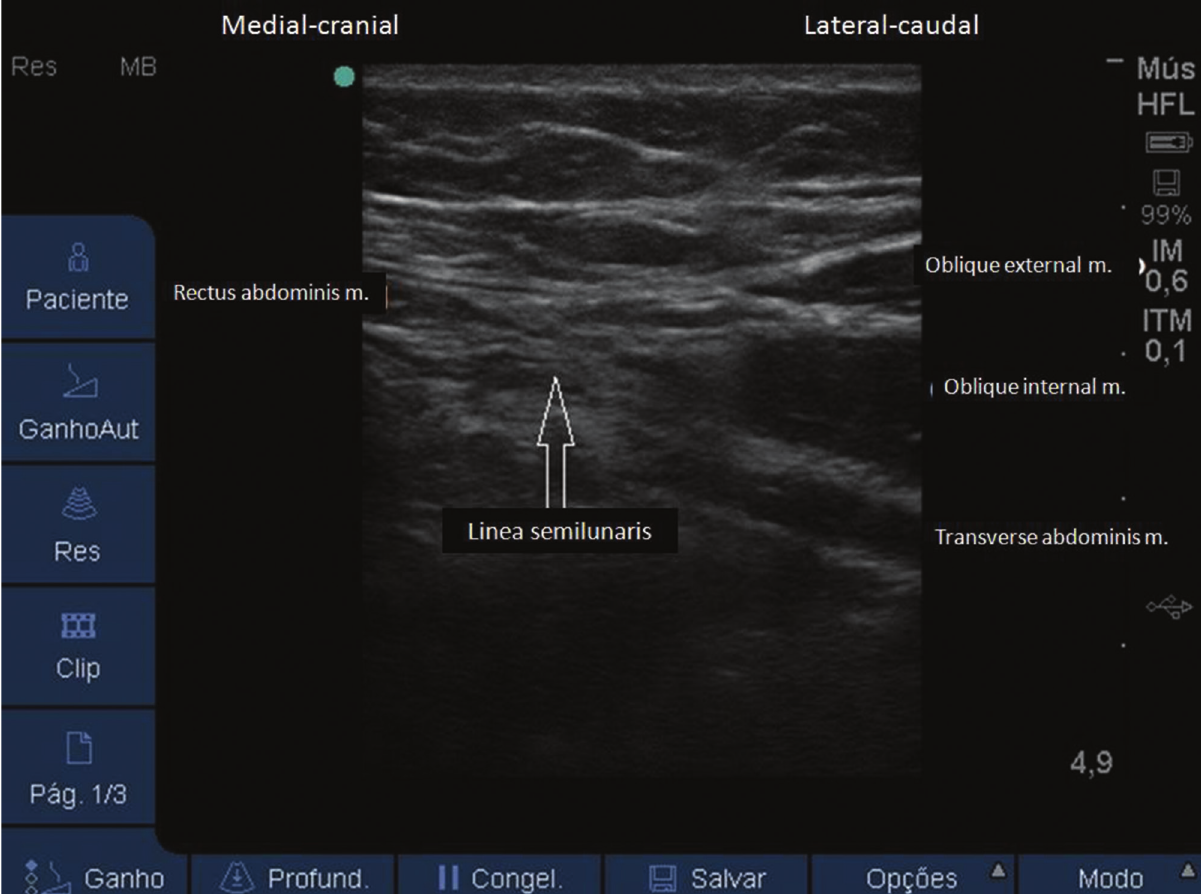
Figure 6 - Ultrasound image with visualization of the lateral portion of the RA muscle, linea semilunaris and abdominal muscles planes